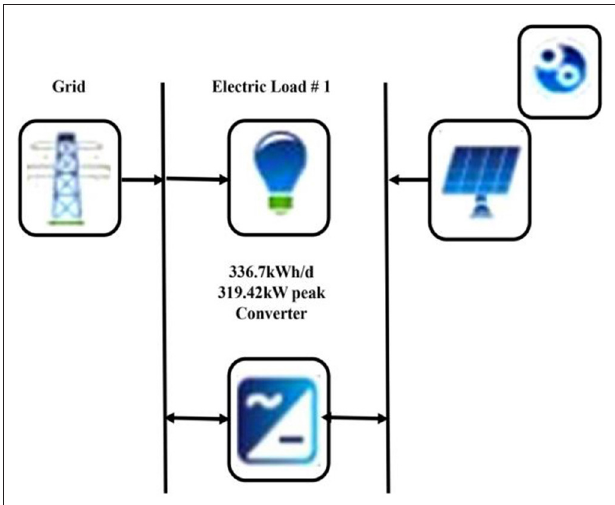
FIGURE 10 | Hybrid NZEB schematic for selected building in HOMER Pro.